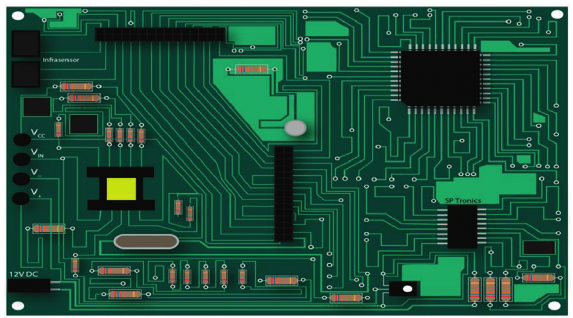
Figure 1: Printed circuit board schematic